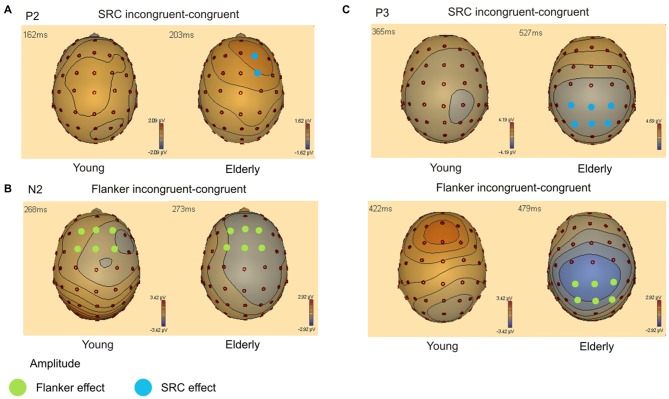
(A) Topography of amplitude difference between SRC incongruent—congruent condition for the P2 component (140–220 ms). Blue circles indicate electrodes with a significant SRC amplitude effect. (B) Topography of amplitude difference between Flanker incongruent—congruent condition for the N2 component (240–330 ms). Green circles represent electrodes with a significant Flanker conflict amplitude effect. (C) Topography of amplitude difference between SRC and Flanker incongruent—congruent condition for the P3 component (310–570 ms). Colored circles indicate significant SRC (blue) and Flanker conflict (green) amplitude effects.